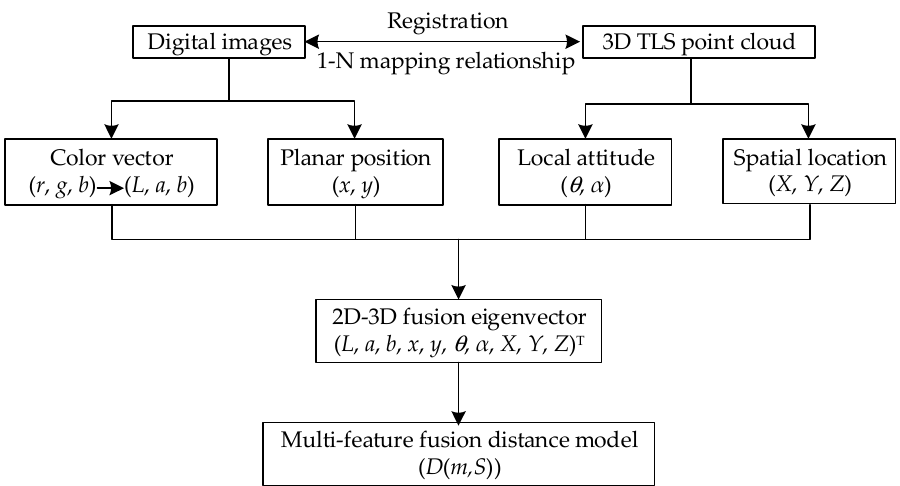
Figure 6. The flowchart of distance measure model construction.